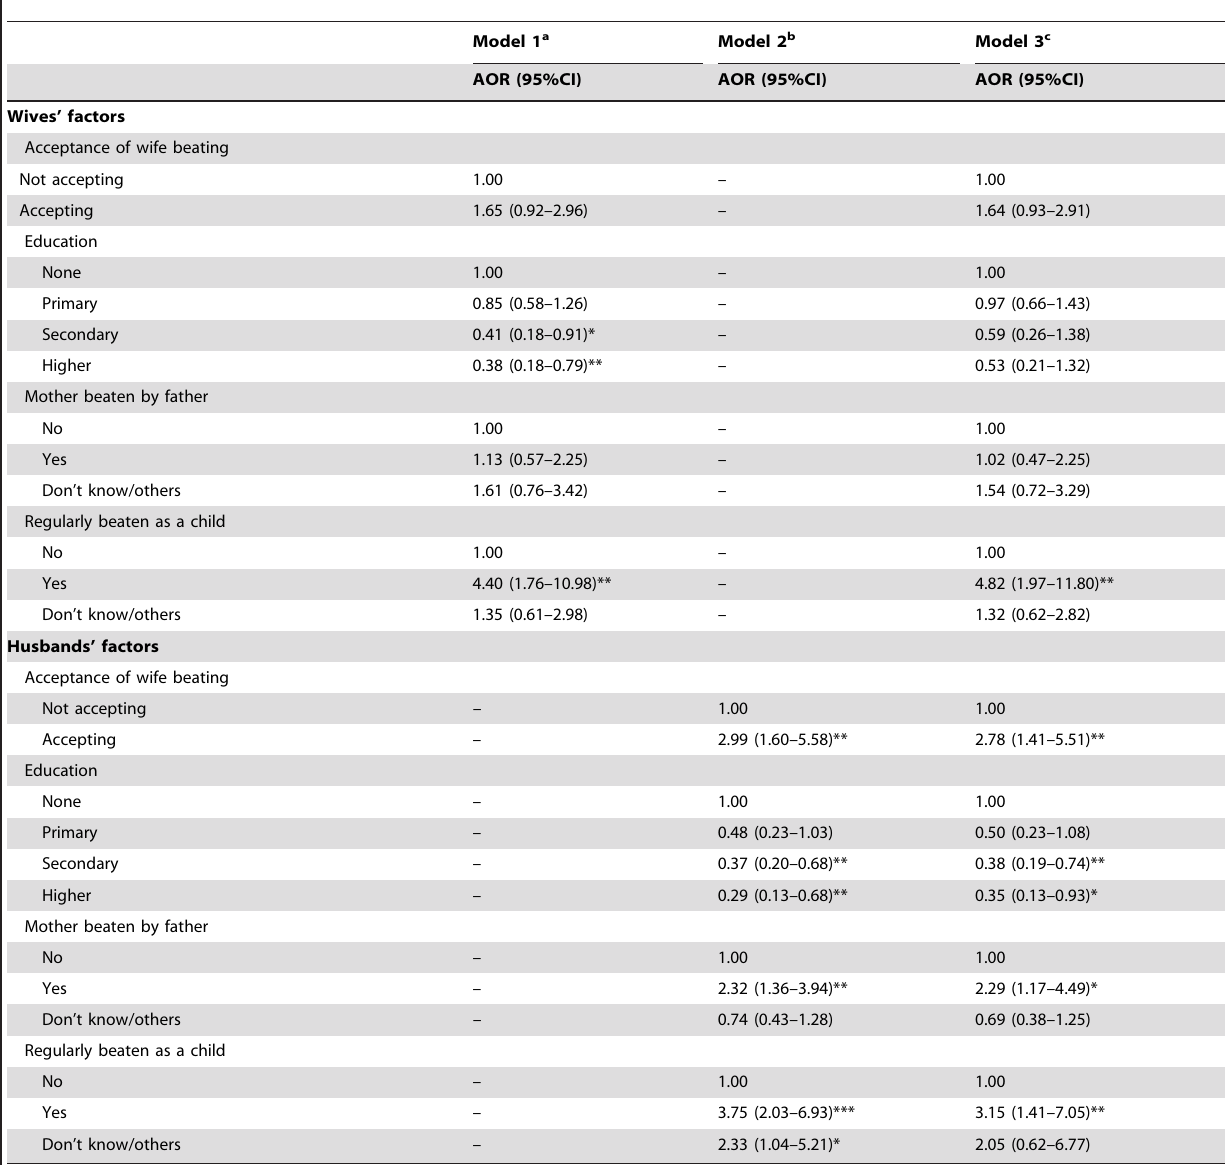
Table 5. Association between acceptance of wife beating among couples and past 1-year physical IPV towards